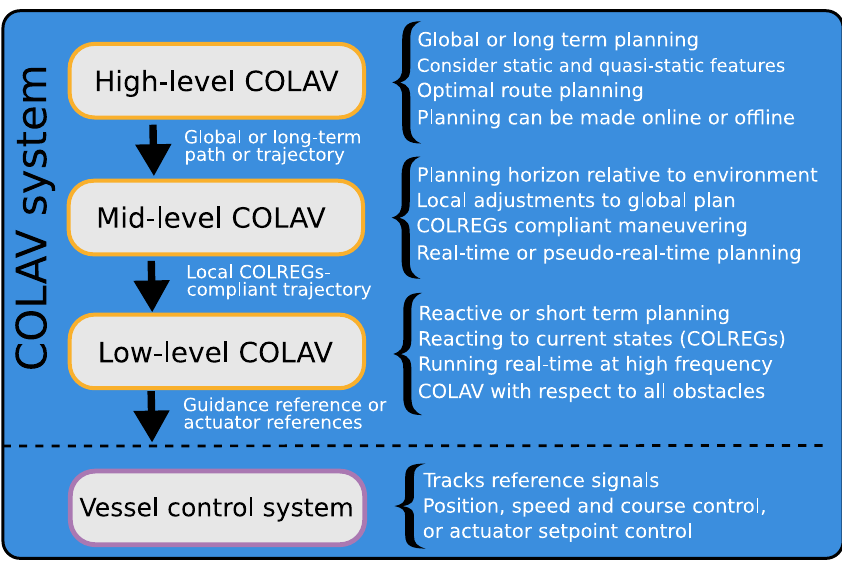
Figure 2: Three-layer hybrid COLAV structure, where the responsibility of path planning, trajectory planning, and reactive maneuvering is distributed over three separate methods. The figure is inspired by Eriksen and Breivik